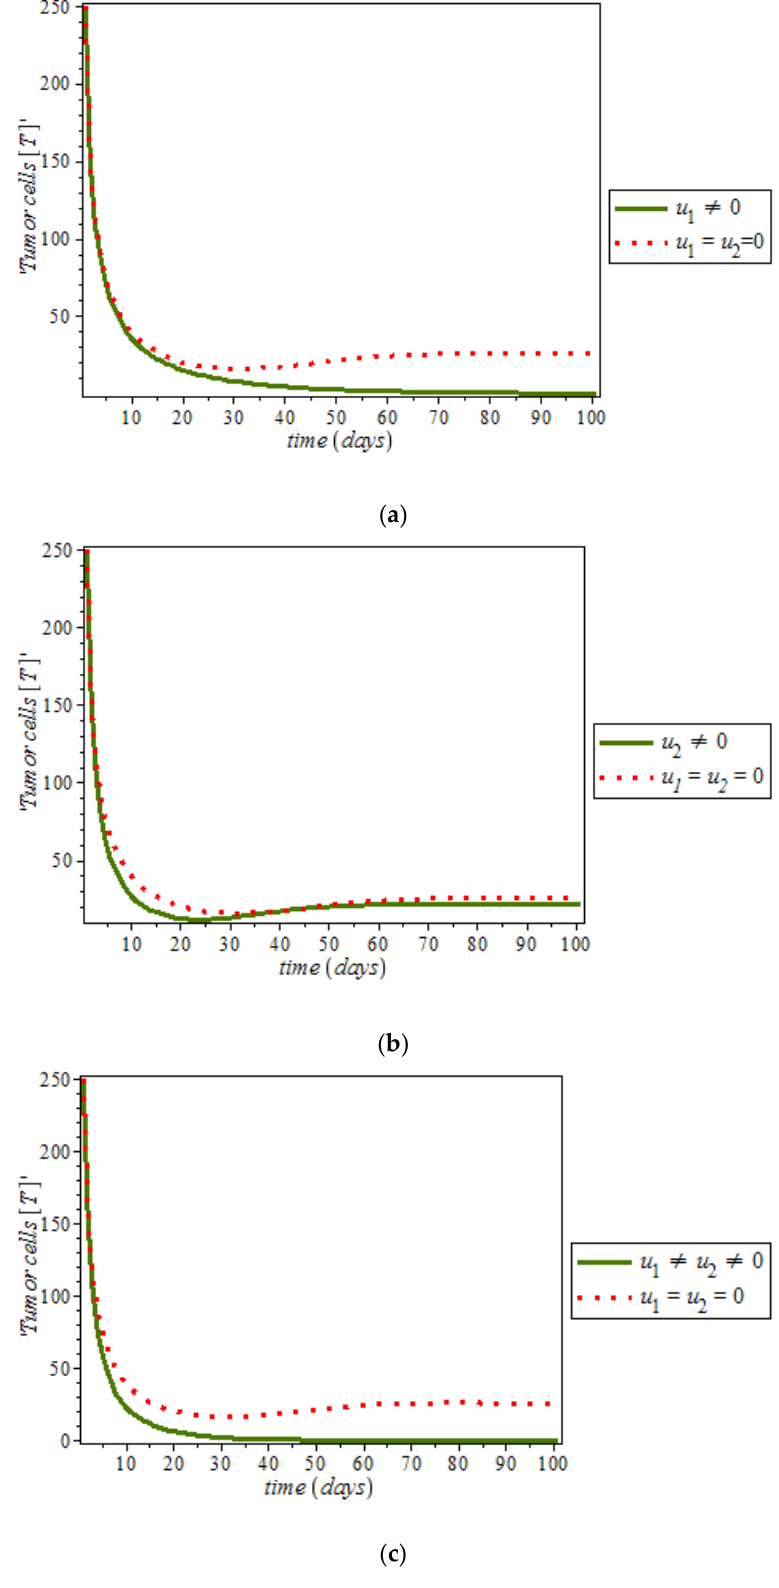
Figure 11. Simulation result of the model (9), showing tumor cell population against time with and without control